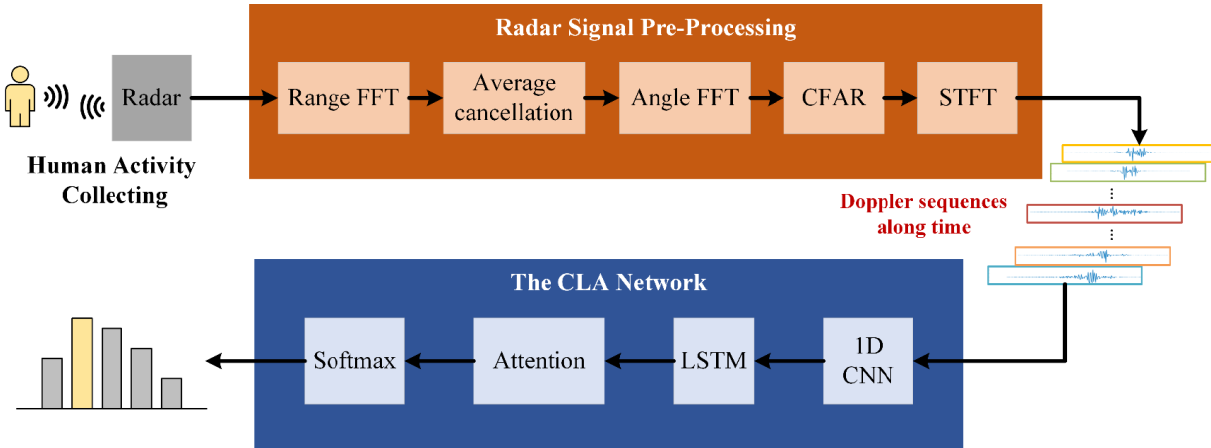
Figure 1. Proposed HAR system.